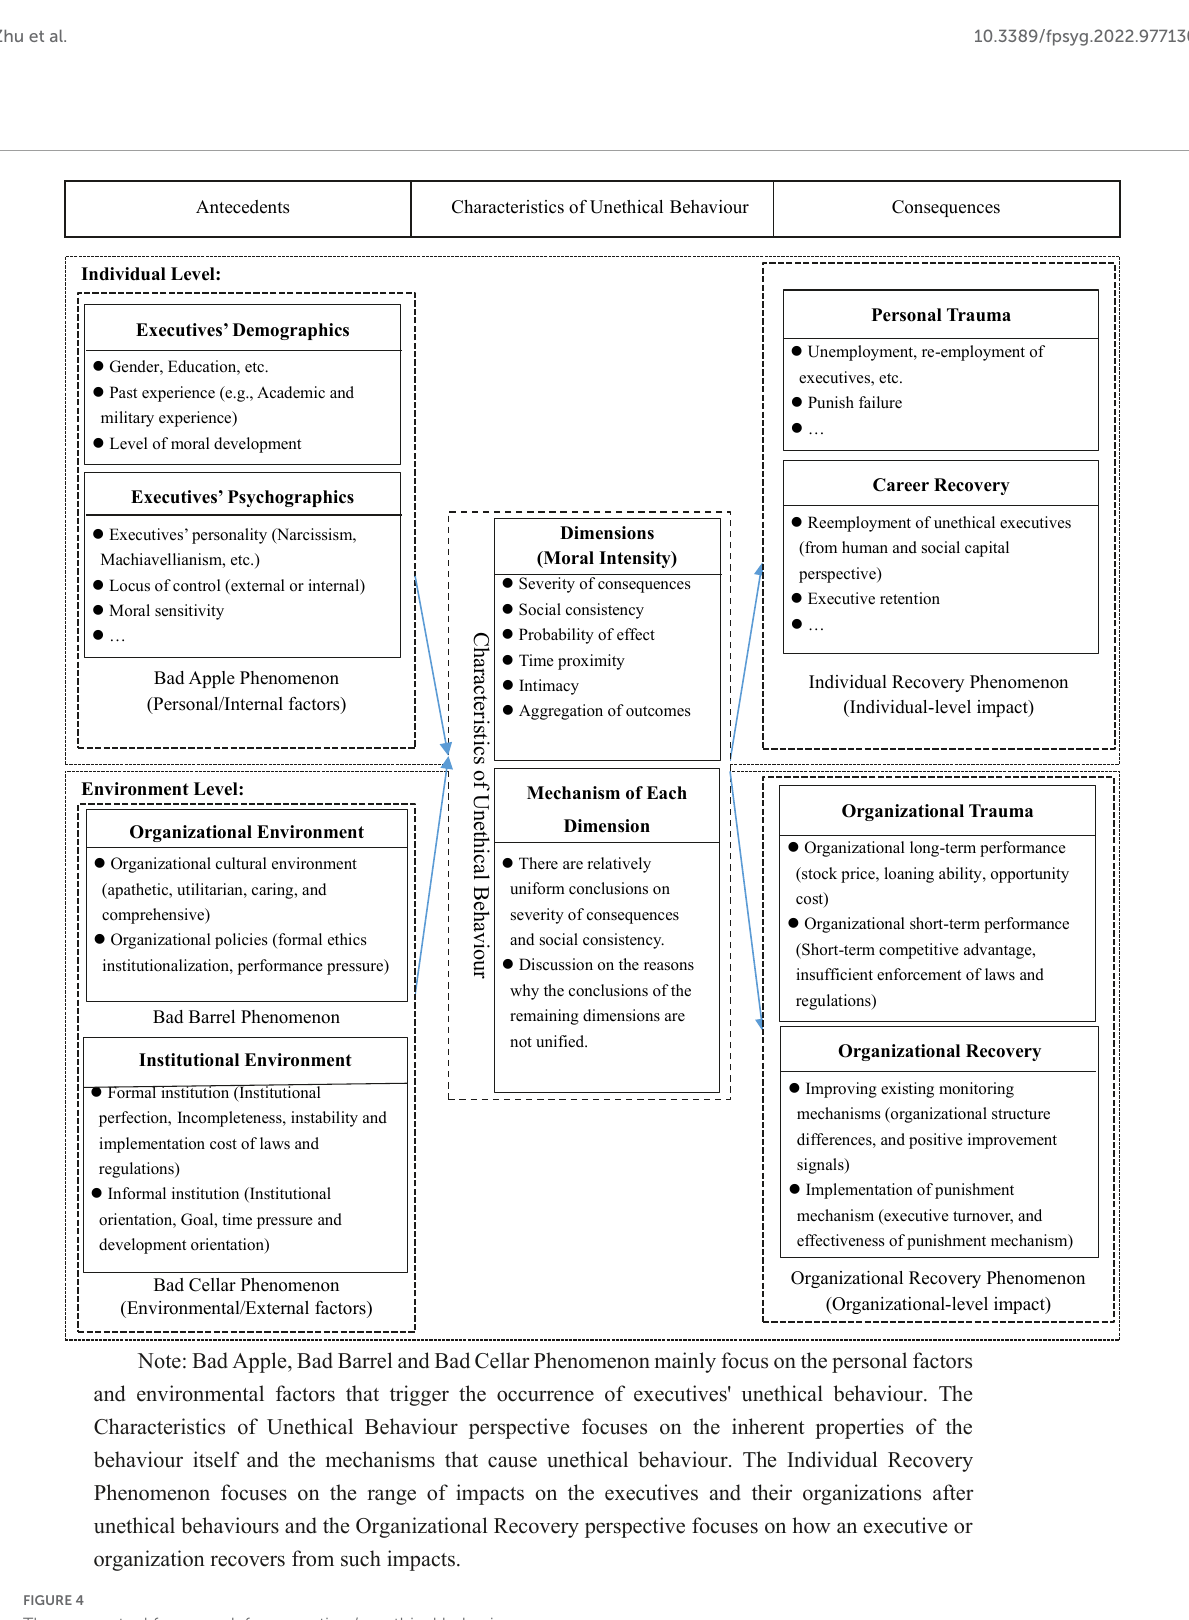
level. Prior studies mainly explored the impact of unethical behaviour on executives (e.g., reputational damage, turnover, etc.) or organisations (e.g., organisational long- and short-term